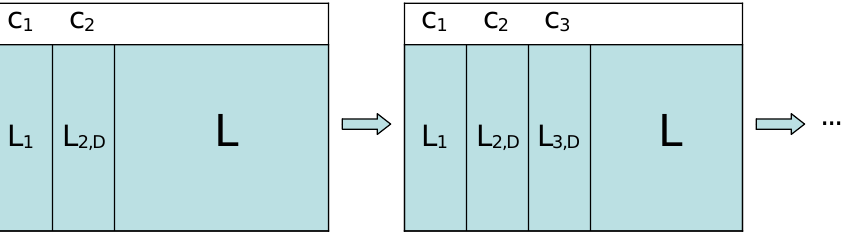
Figure 5 . Second pattern of positive components: column-wise